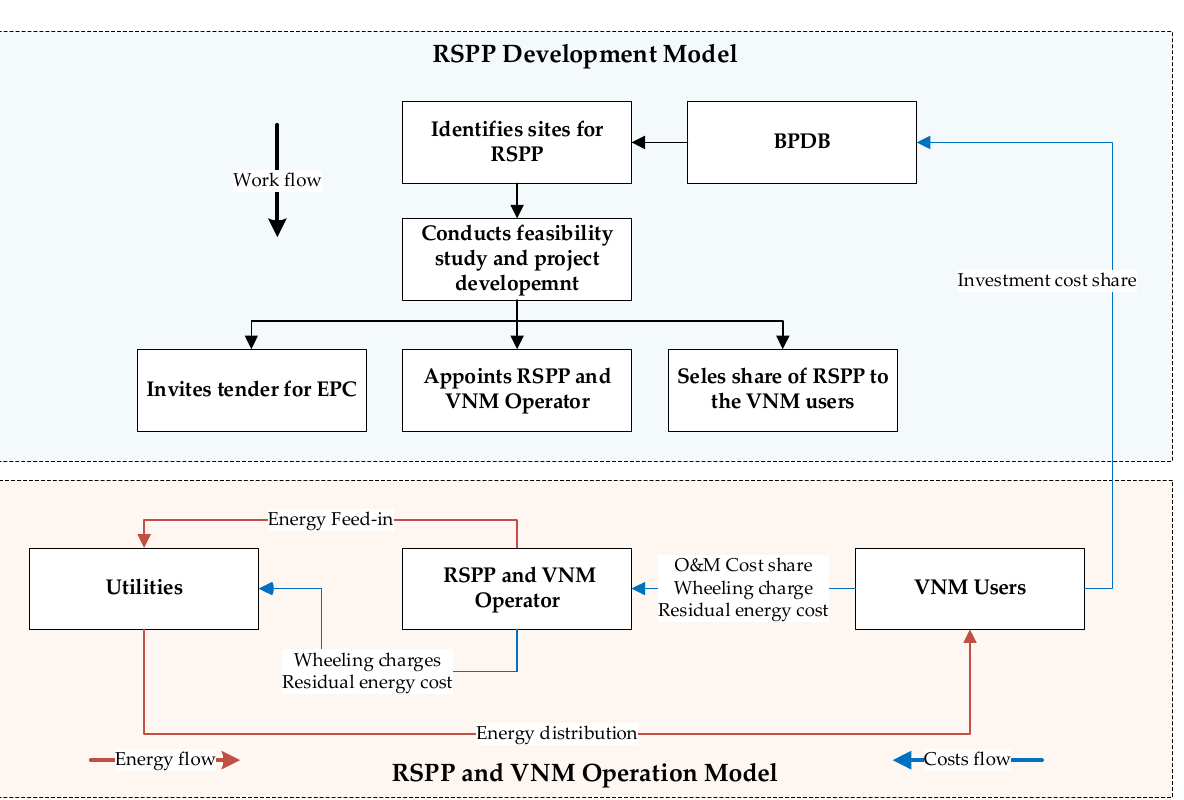
Figure A1. Proposed model for VNM implementation in Bangladesh.